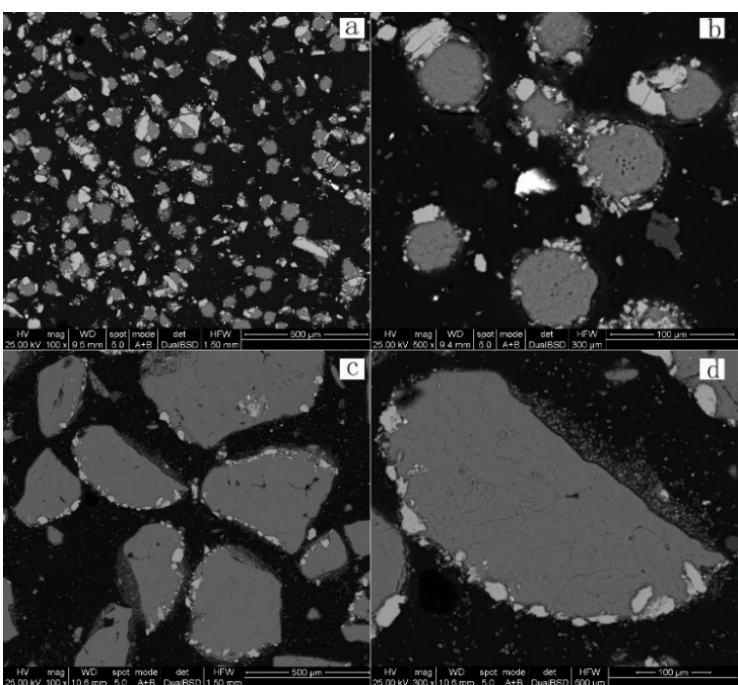
Figure 21. BSE images of leach residues ( a , b ) leaching time of 0.5 h; ( c , d ) leaching time of 2.5 h.